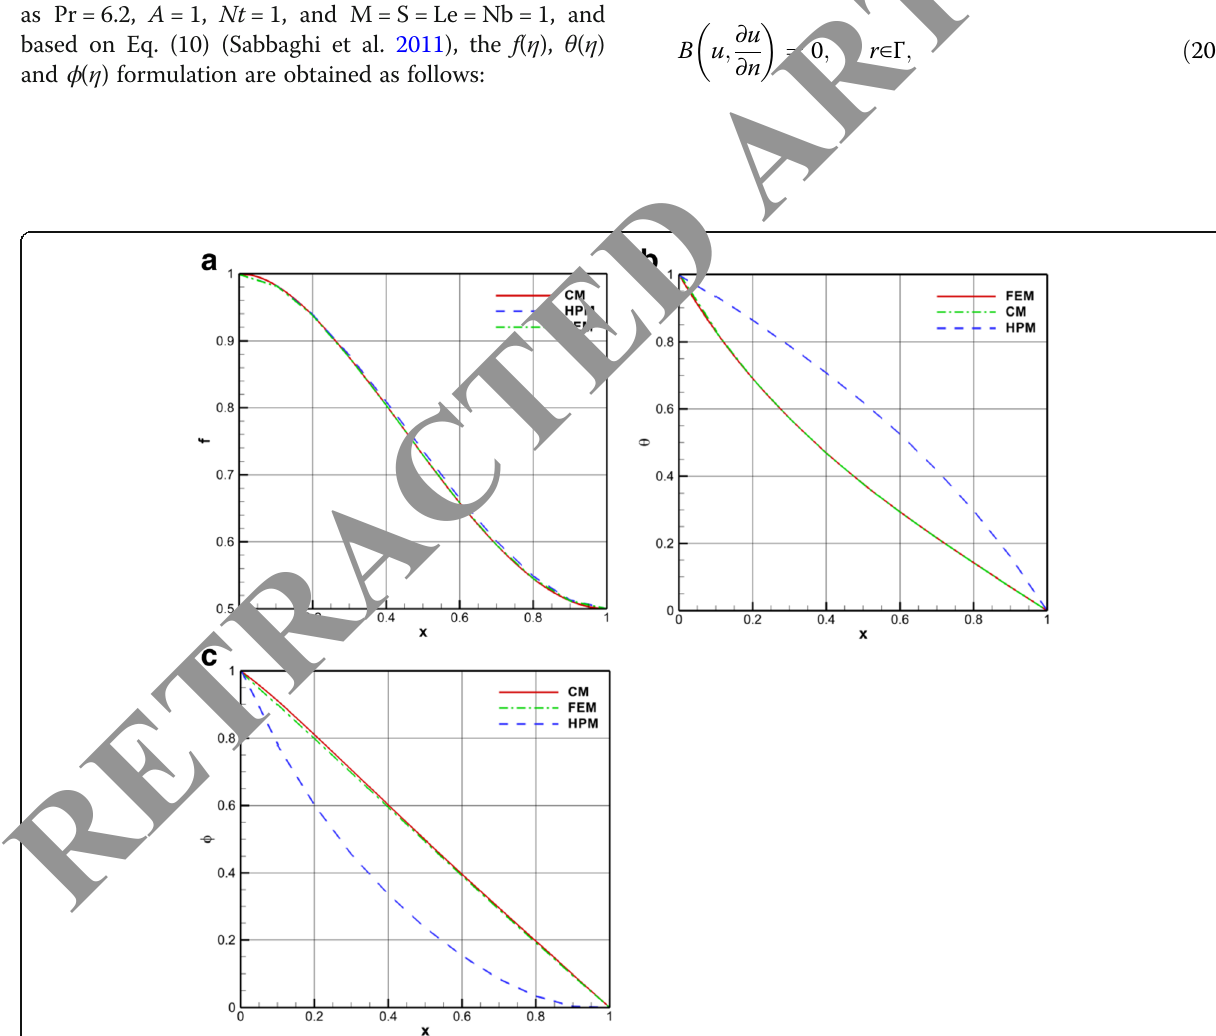
Fig. 2 a Comparison velocity profile of the solutions via CM, HPM, and numerical solution for A = 1, M = 1, S = 1, Le = 1, Nb = 1, Nt = 0.1, Pr = 6.2. b Comparison temperature profile of the solutions via CM, HPM, and numerical solution for A = 1, M = 1, S = 1, Le = 1, Nb = 1, Nt = 0.1, Pr = 6.2. c Comparison concentration profile of the solutions via CM, HPM, and numerical solution for A = 1, M = 1, S = 1, Le = 1, Nb = 1, Nt = 0.1, Pr =